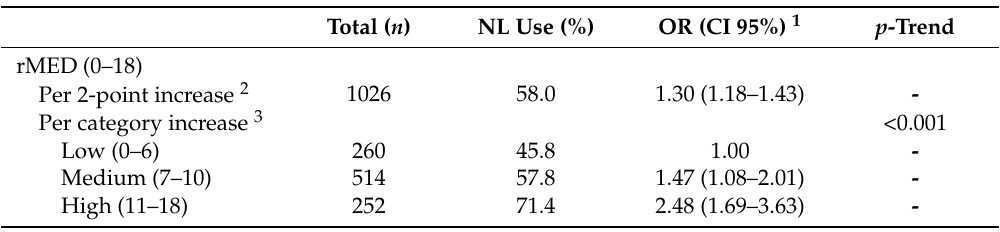
Table 3. Relationship between adherence to the Mediterranean Diet (rMED) and nutrition labelling use in participants aged 17–35 from the DiSA-UMH study, Spain ( n = 1026).